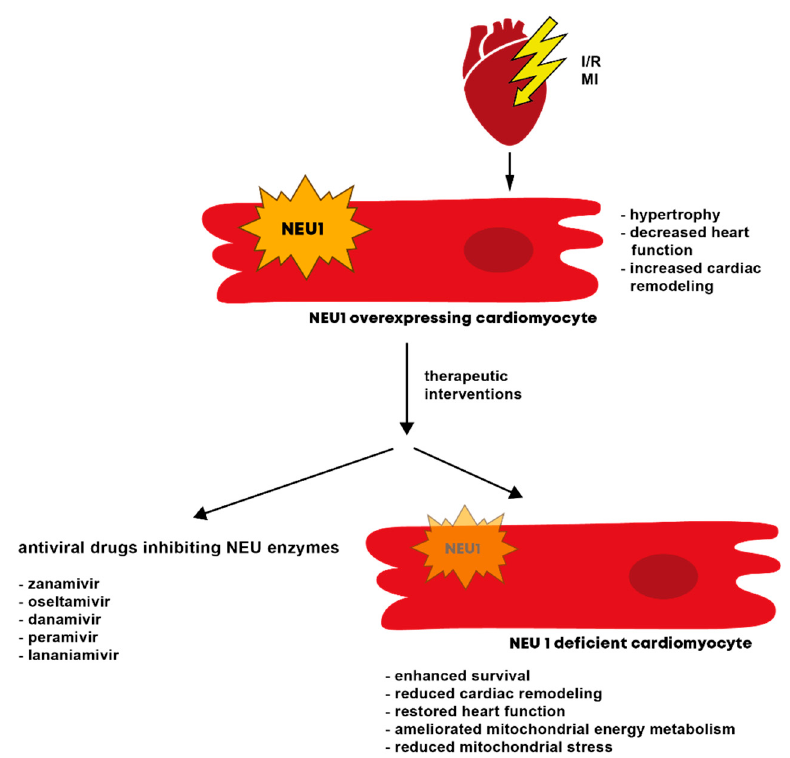
Figure 3. Scheme illustrating the consequences of an altered NEU1 expression on the heart. NEU1 is upregulated in the heart early after I/R and MI. Mice with NEU1 overexpressing cardiomyocytes show hypertrophy, a decrease in heart function and increased cardiac remodelling. Possible therapeutic options to decrease NEU1 expression after an ischemic insult are antiviral drugs inhibiting NEU enzymes or genetic modifications. Mice with NEU1 deficient cardiomyocytes show enhanced survival, reduced cardiac remodelling, a restored heart function, ameliorated mitochondrial energy metabolism and reduced mitochondrial stress. Therefore, the listed antiviral drugs inhibiting NEU enzymes could be a new therapeutic approach with beneficial effects in patients suffering from cardiovascular disease. Abbreviations: NEU1, neuraminidase 1.